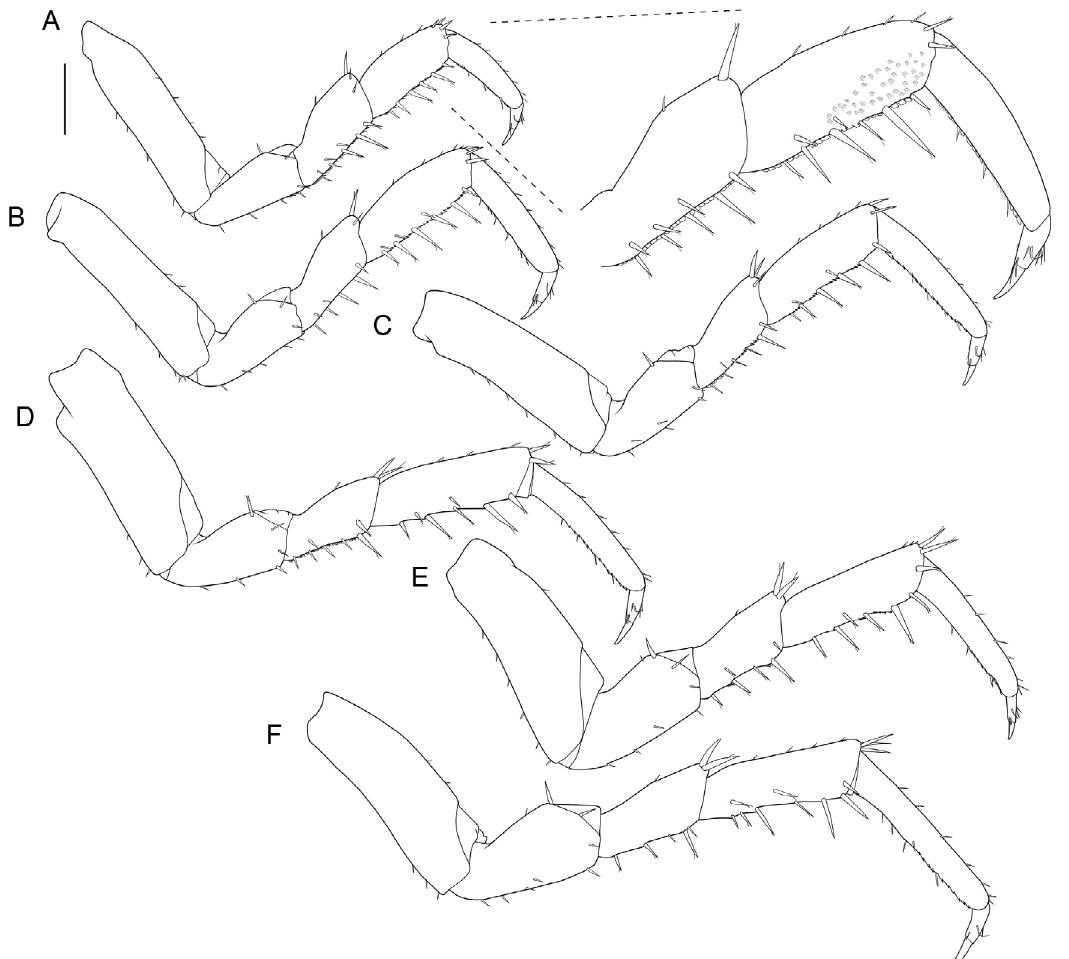
Figure 7. Spelunconiscus septemlacuum sp. nov. A – F : Pereopods 1 – 6. Scale bar: 0.2